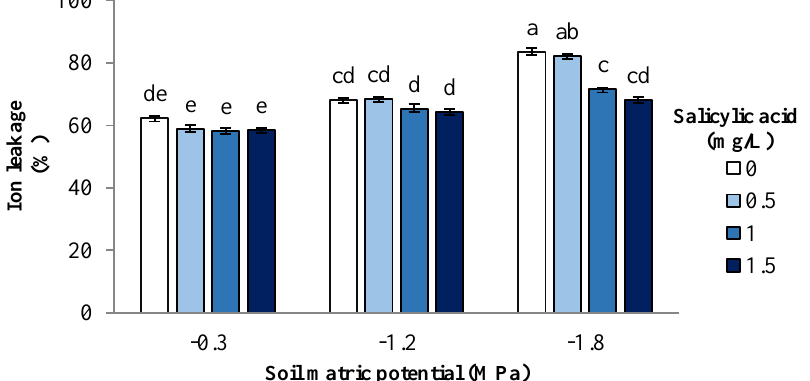
Figure 2. Interaction effects of controlled water stress and foliar application of SA on ion leakage percent of pumpkin